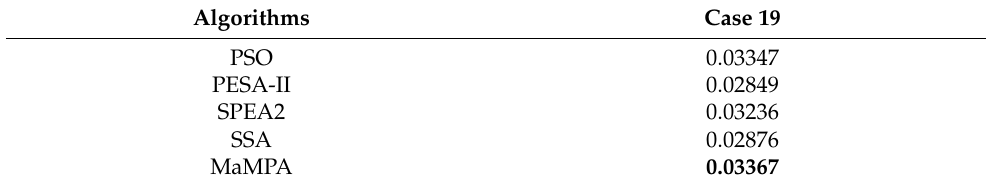
Table 14. Hypervolume comparison of MaOPF problems in the IEEE 30-bus system. Algorithms Case 19 PSO